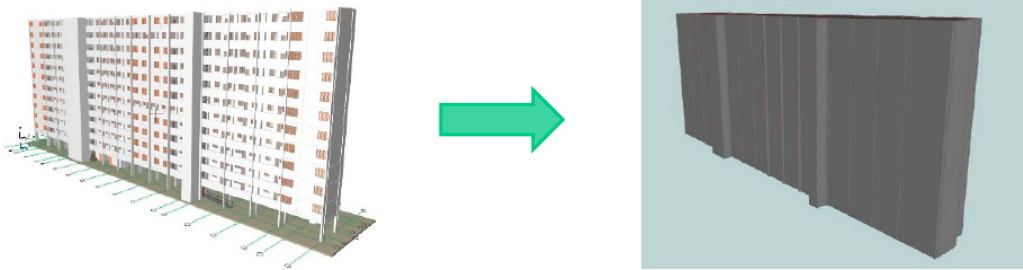
Figure 3. IFC Archicad model ( left ) transformed into CityGML LOD2 model ( right ).